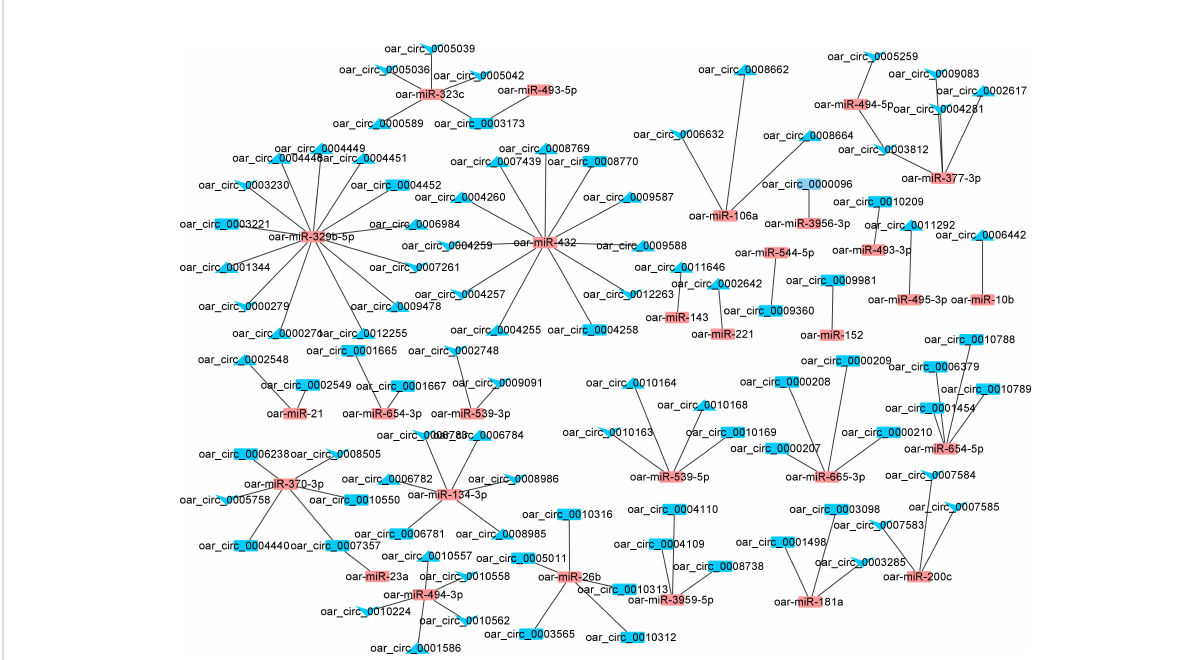
FIGURE 7 The networks of circRNA-miRNA for SP42-LP42. Blue and orange represent miRNAs and circRNAs, respectively. Triangle and V represent upregulated and downregulated,